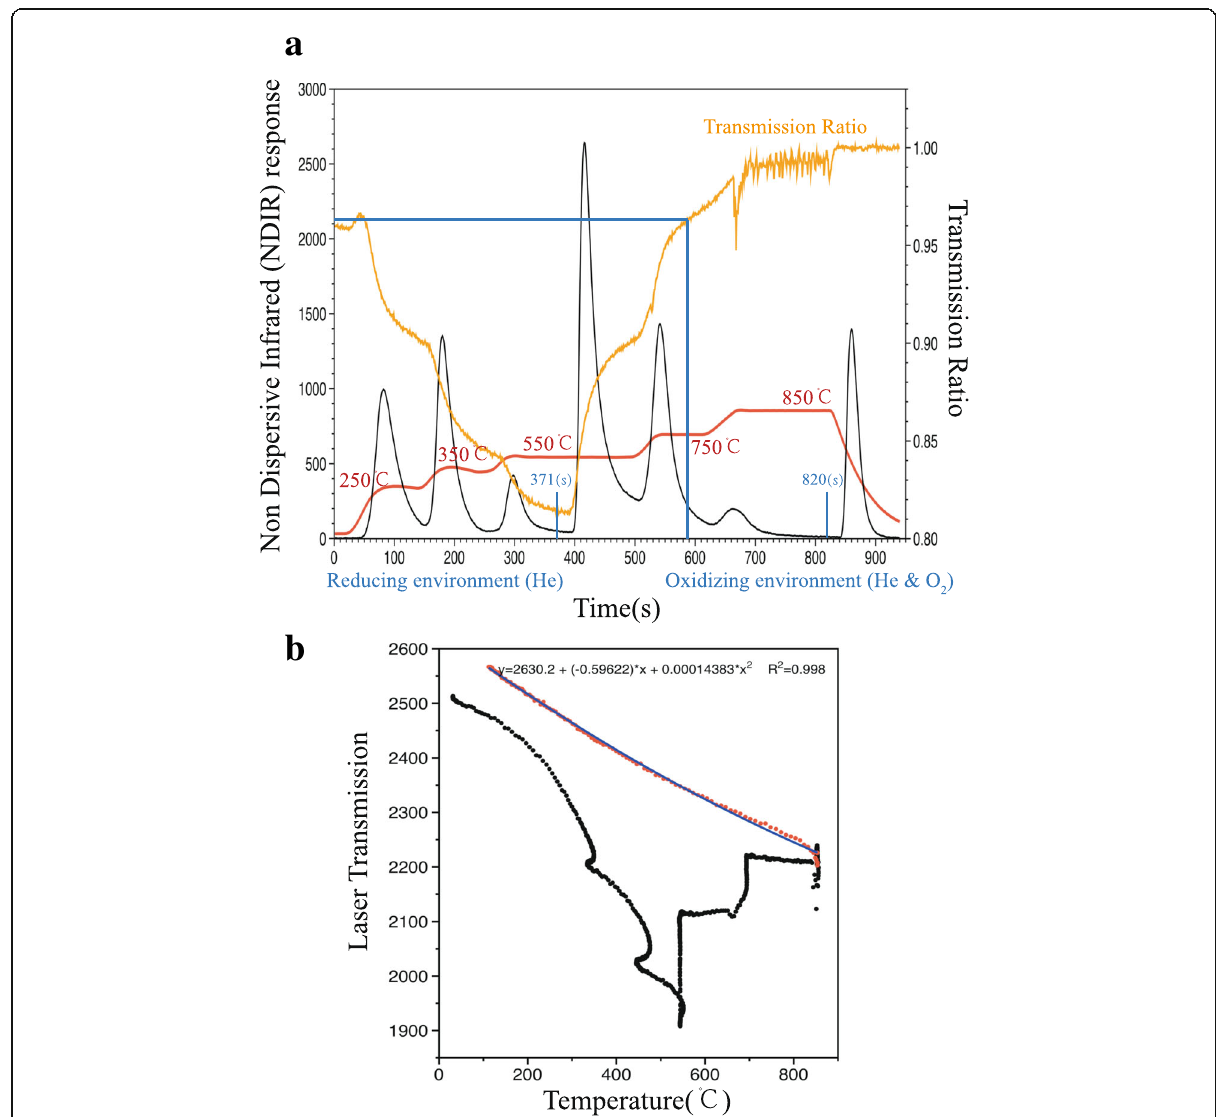
Fig. 4 a An example thermal optical transmittance (TOT) thermogram. Temperature change is represented as red line, and the corrected laser transmission ratio is represented by orange line. The carbon fraction detected by NDIR response is represented as black line. b The relationship between the ambient temperature and the original laser transmission generated by a Semi-Continuous OCEC Carbon Aerosol Analyzer manufactured by Sunset Laboratory. The temperature dependency of the raw laser transmission values was calibrated using a quadratic relationship, with the ambient temperatures shown as red